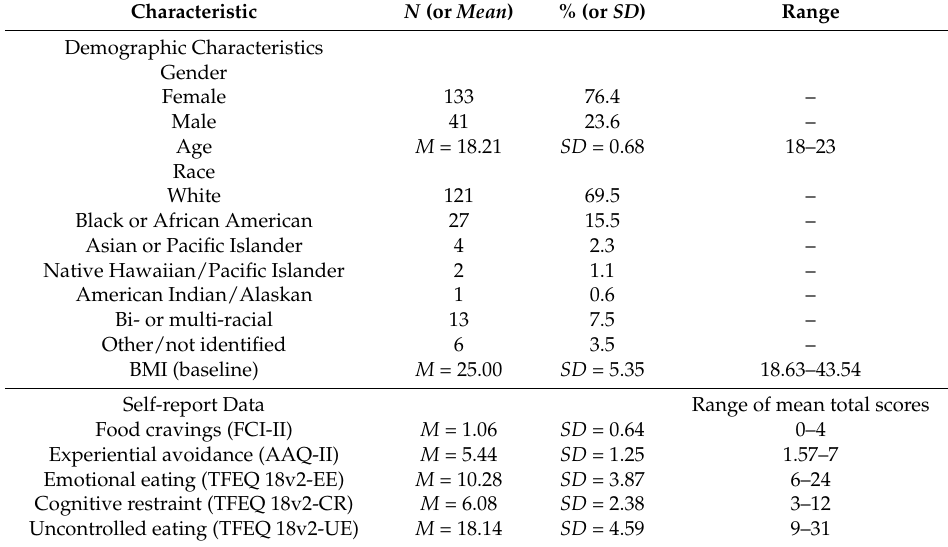
Table 1. Demographic Characteristics and Descriptive Data of Study Sample ( n = 174). Notes.